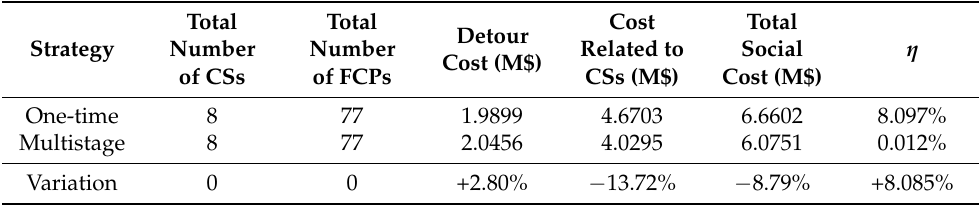
Table 2. Comparison of the optimization results of the one-time optimization strategy and the multistage optimization strategy.